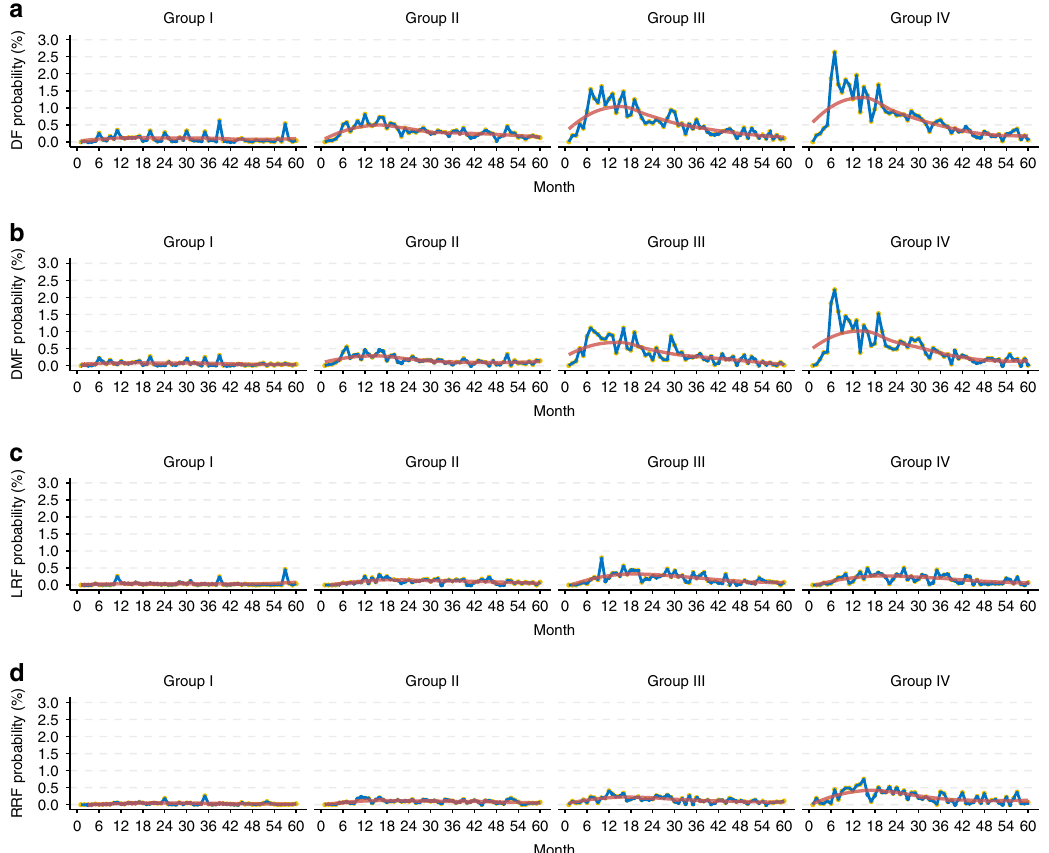
Fig. 2 Time-speci fi c occurrence probabilities of different staging groups in nasopharyngeal carcinoma patients. Disease failure ( a ); distant metastasis ( b ); local recurrence ( c ) and regional recurrence ( d ). Number of patients: group I, n = 367; group II, n = 3472; group III, n = 1863; group IV, n =